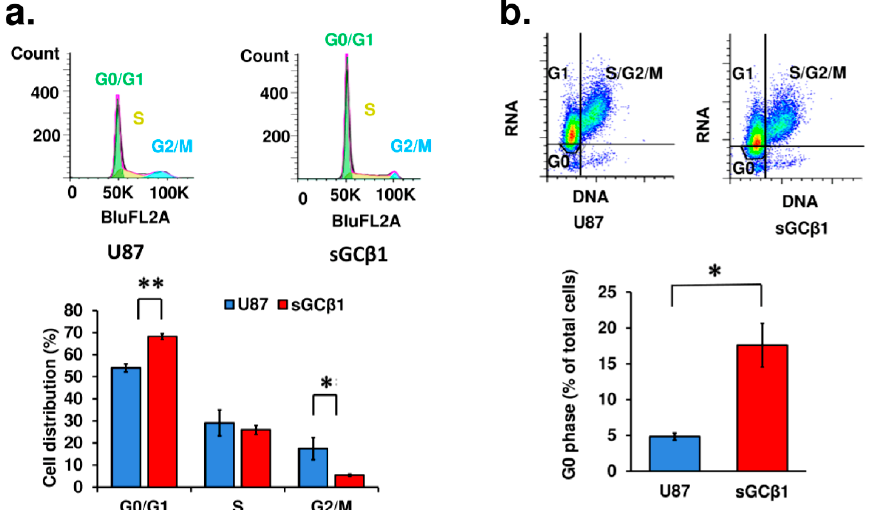
Figure 3. Cell cycle and proliferation/survival analysis of sGC β 1-overexpressing cells. ( a ) Cell cycle analysis of sGC β 1-overexpressing cells stained with propidium iodide by flow cytometry. G0/G1, S, and G2/M phases are indicated. ( b ) DNA and RNA content analysis of sGC β 1-overexpressing cells stained with 7AAD and Pyronin Y by flow cytometry. S/G2/M, G1, and G0 phase are indicated. The data were analyzed by using FlowJo software. The data are the mean ± S.E.M. *, p < 0.05; **, p < 0.01 (vs. empty vector or control).